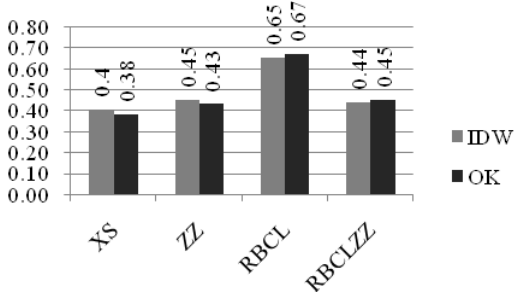
Figure 9. Root Mean Square Error (RMSE) of the interpolated river bed surfaces using an independent set of 1,500 random points.